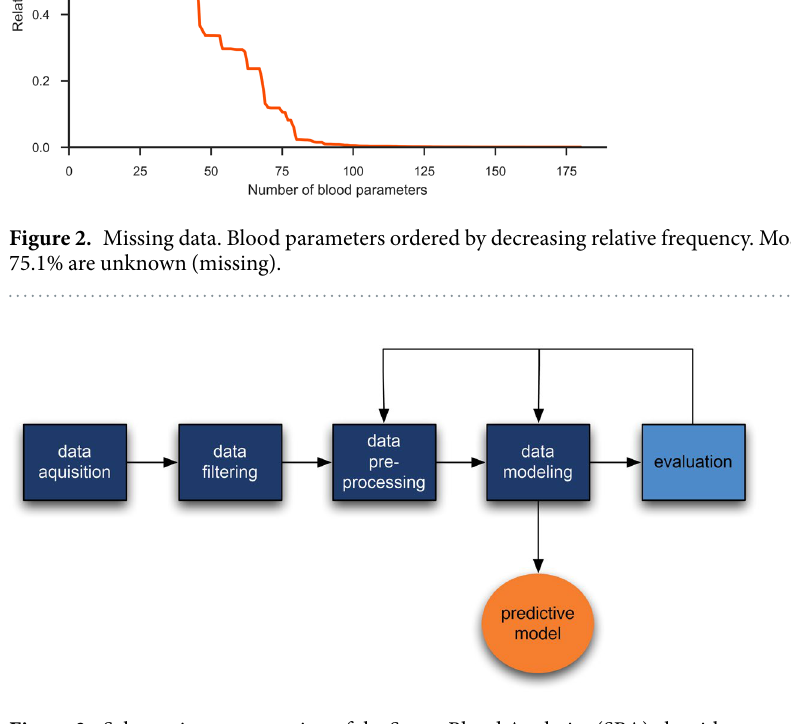
Figure 3. Schematic representation of the Smart Blood Analytics (SBA) algorithm